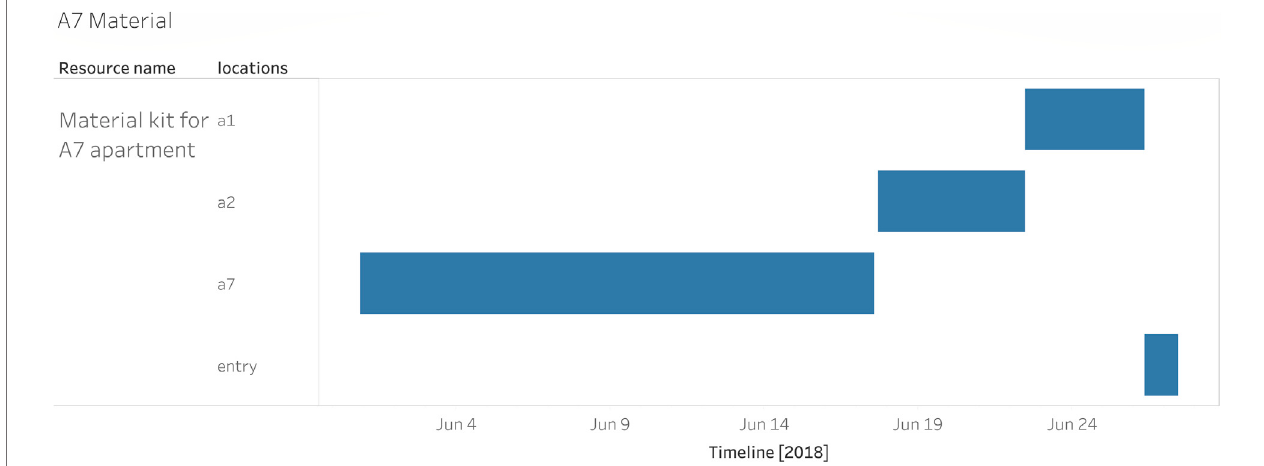
FIGURE 7 | Material fl ow of the material kit for apartment A7 inside the building.